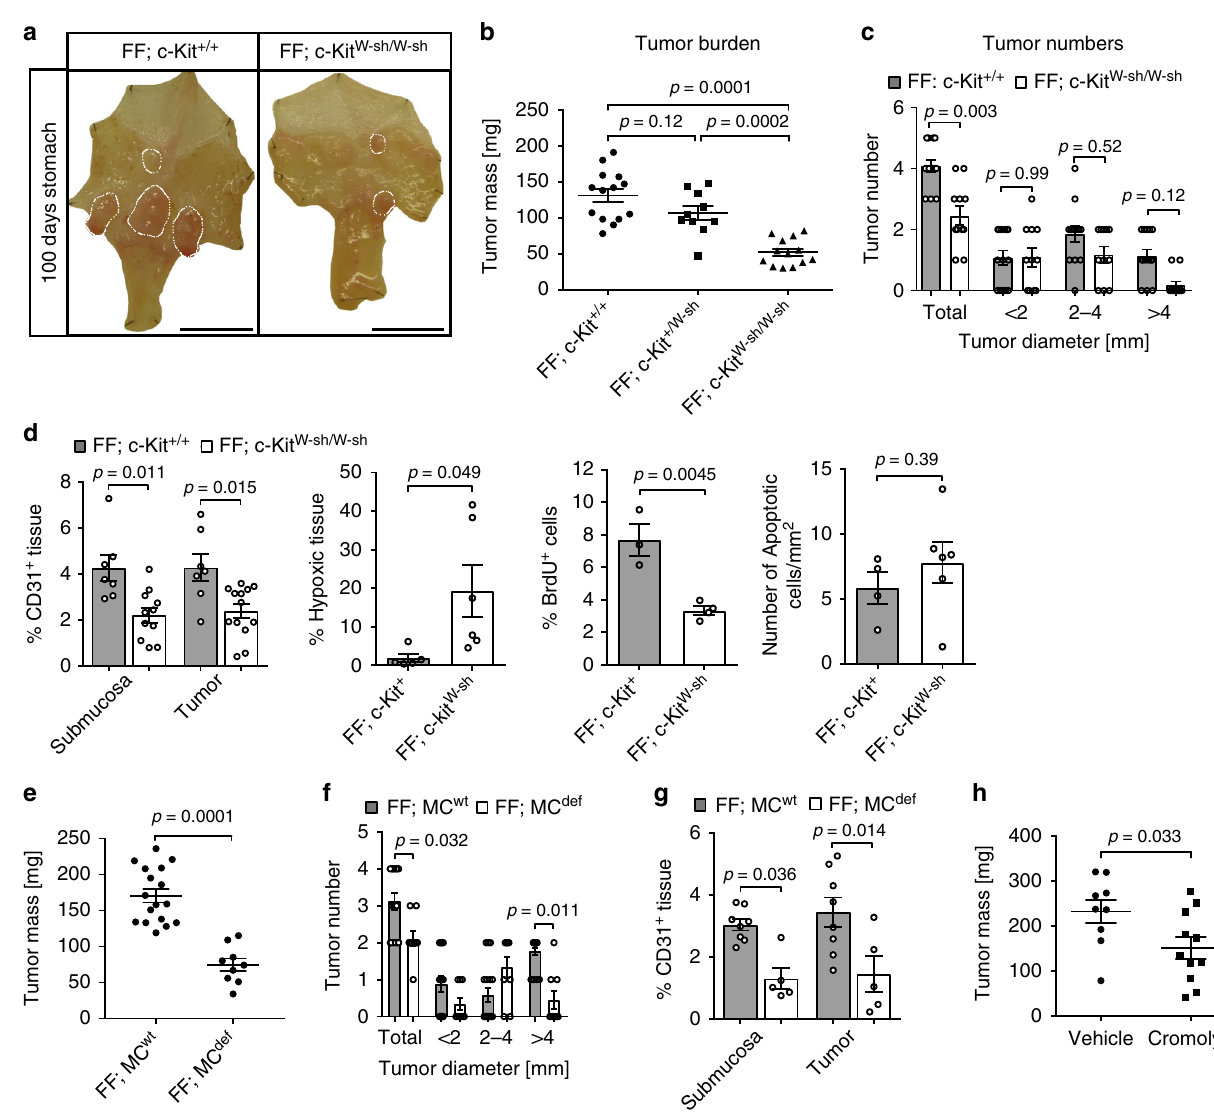
Fig. 2 Gastric tumor burden is reduced in mast cell – de fi cient gp130 FF tumor mice. a Representative whole mounts of pinned out stomachs, from 100-day- old gp130 FF ; c-Kit + / + and mast cell-de fi cient gp130 FF ; c-Kit W-sh/W-sh mice. Scale bars = 1 mm. b Quanti fi cation of total tumor burden per mouse as in ( a ). Each symbol represents an individual mouse. One-way ANOVA F (DFn, Dfd) = 25.97 (2, 24). c Enumeration of total tumor number and tumor size distribution as in a from gp130 FF ; c-Kit + / + ( n = 14) and gp130 FF ; c-Kit W-sh/W-sh mice ( n = 11). One-way ANOVA F (DFn, Dfd) = 24.59 (7, 92). d Quanti fi cation of CD31, Hypoxyprobe (hypoxia), BrdU (proliferation), or ApopTag (apoptosis) on immunostained gastric tumors sections. Number of mice (n) for CD31: FF; c-Kit + / + n = 7, FF; c-Kit W-sh/W-sh n = 11 with ANOVA F (DFn, Dfd) = 7.075 (3, 34); Hypoxyprobe: FF; c-Kit + n = 5, FF; c-Kit W-sh n = 6 with t -test + Welch correction ’ s t (df) = 2.55 (5.256); BrdU: FF; c-Kit + n = 3, FF; c-Kit W-sh n = 4 with t -test ’ s t (df) = 4.905 (5); Apoptosis: FF; c-Kit + n = 4, FF; c-Kit W-sh n = 6 with t -test ’ s t (df) = 0.89 (8). e Quanti fi cation of total tumor burden per mouse of mast FF; MC wt (genotypes: FF; Cpa3-Cre neg ; Mcl1 fl / fl and FF,Cpa-Cre;Macl1 + / + ) and mast cell-de fi cient FF; MC def (genotype: FF; Cpa3-Cre; Mcl1 fl / fl ) mice. t -test ’ s t (df) = 6.72 (24). f Enumeration of the tumor number per mouse of FF; MC wt ( n = 17 mice) and mast cell-de fi cient FF; MC def ( n = 9 FF; Cpa3-Cre; Mcl1 fl / fl mice). One-way ANOVA F (DFn, Dfd) = 23.25 (7, 96). g CD31 angiogenic staining quanti fi cation of stomachs from ( e , f ). FF; MC wt ( n = 8 mice) and FF; MC def ( n = 5) with one-way ANOVA F (DFn, Dfd) = 6.79 (3, 22). h Quanti fi cation of total tumor burden in gp130 FF mice after 6 weeks administration of cromolyn (mast cell degranulation inhibitor) or vehicle. Each symbol represents an individual mouse and data was generated in three independent experiments. t -test ’ s p value is shown and t (df) = 2.313 (18). Data are represented as mean ± SEM, with p values p < 0.05, being considered signi fi cant. Source data are provided as a Source Data fi le. See also